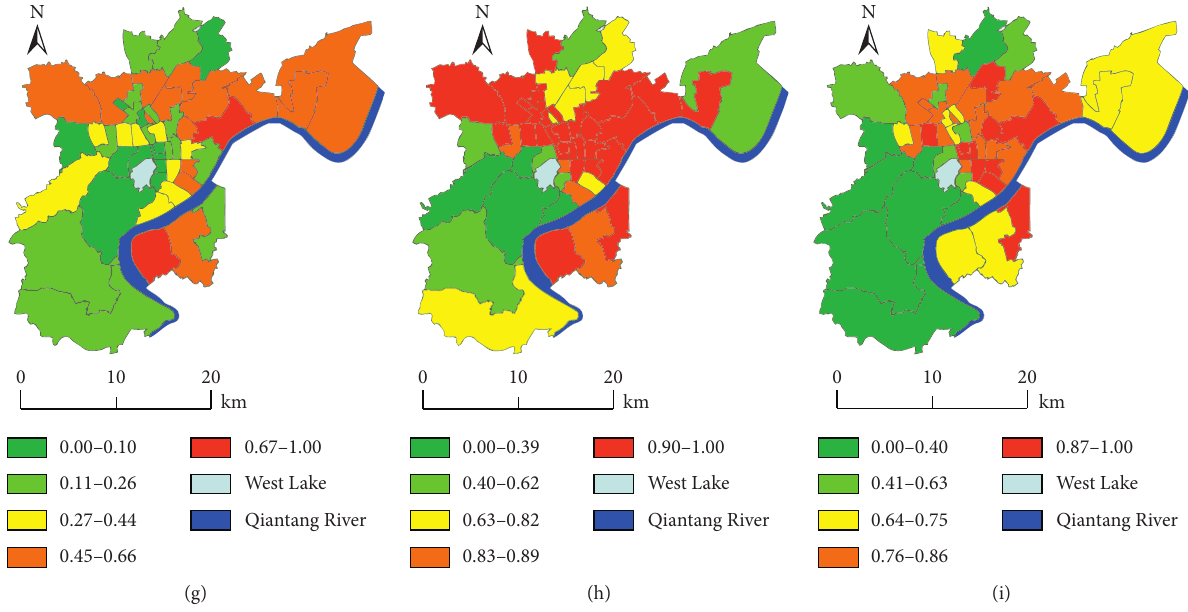
Figure 3: Spatial distribution of heat vulnerability variables in Hangzhou: (a) age ≥ 65 years; (b) age ≥ 60 living alone; (c) illiteracy; (d) income; (e) cool facilities; (f) unhealthy seniors; (g) population less than high school education; (h) lack of green space; (i) LST (same as Figure 2) for Hangzhou at the subdistrict level.